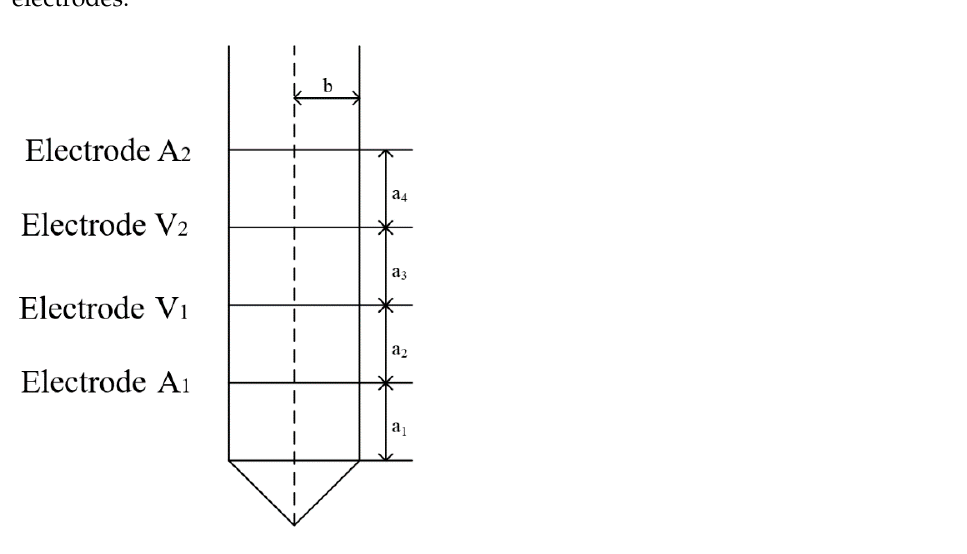
Figure 9. Ring electrode measuring probe. Where a is the distance between the two electrodes, and b is the radius of the probe rod.